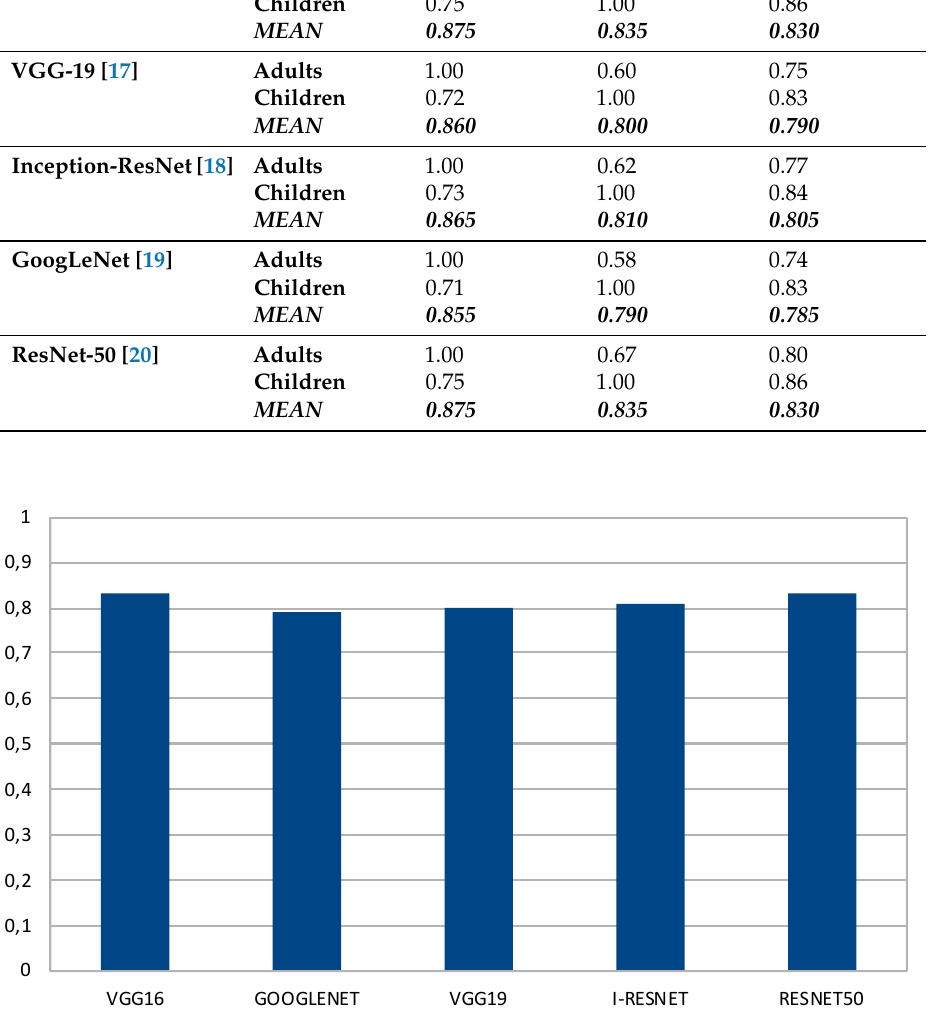
Figure 6. Performance in terms of Deep Convolutional Neural Networks (DCNNs) Accuracy. The best results are achieved by VGG-16 and